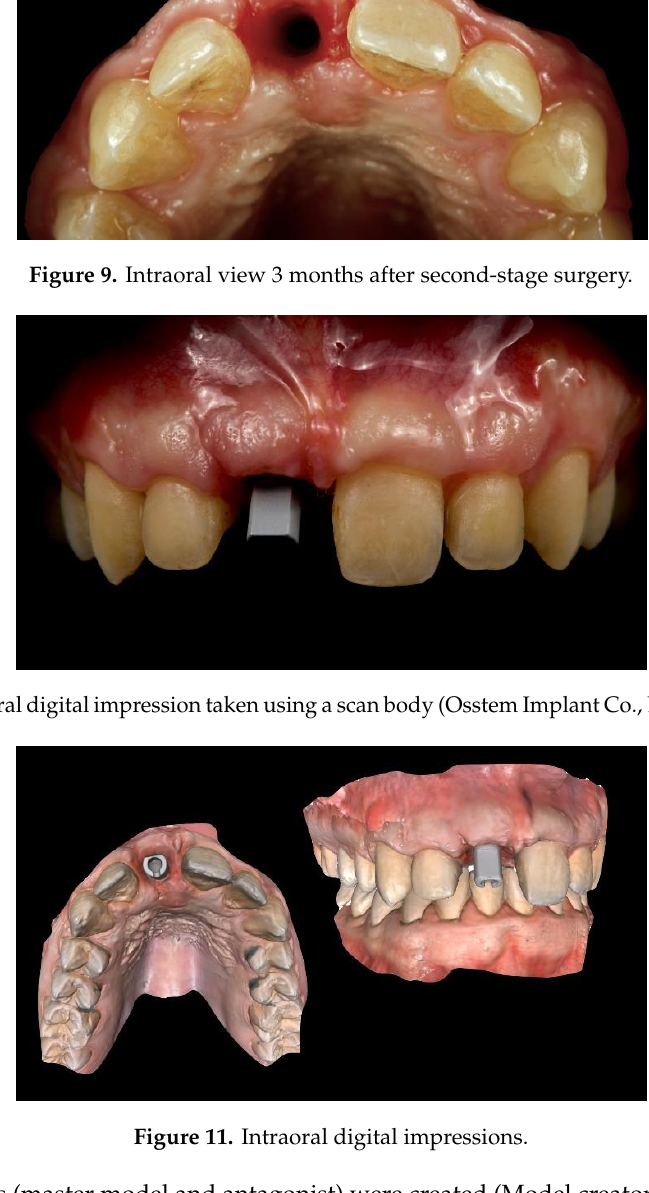
Figure 12. CAD of the definitive restorations. A Digital Lab Analog (Osstem Implant Co., Ltd., Seoul, Korea) was used at the implant position, while a removable abutment was used at the natural tooth position.